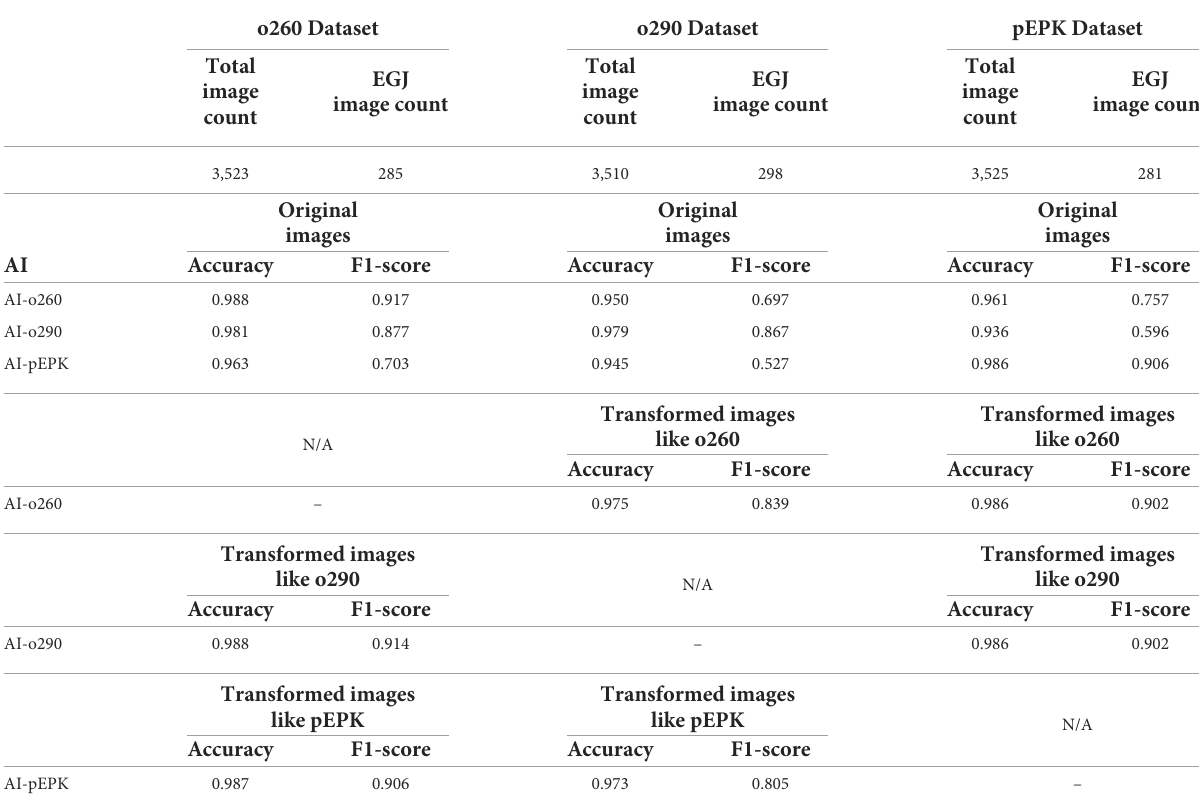
TABLE 2 Comparison of EGJ-recognition performance by AIs in classified validation